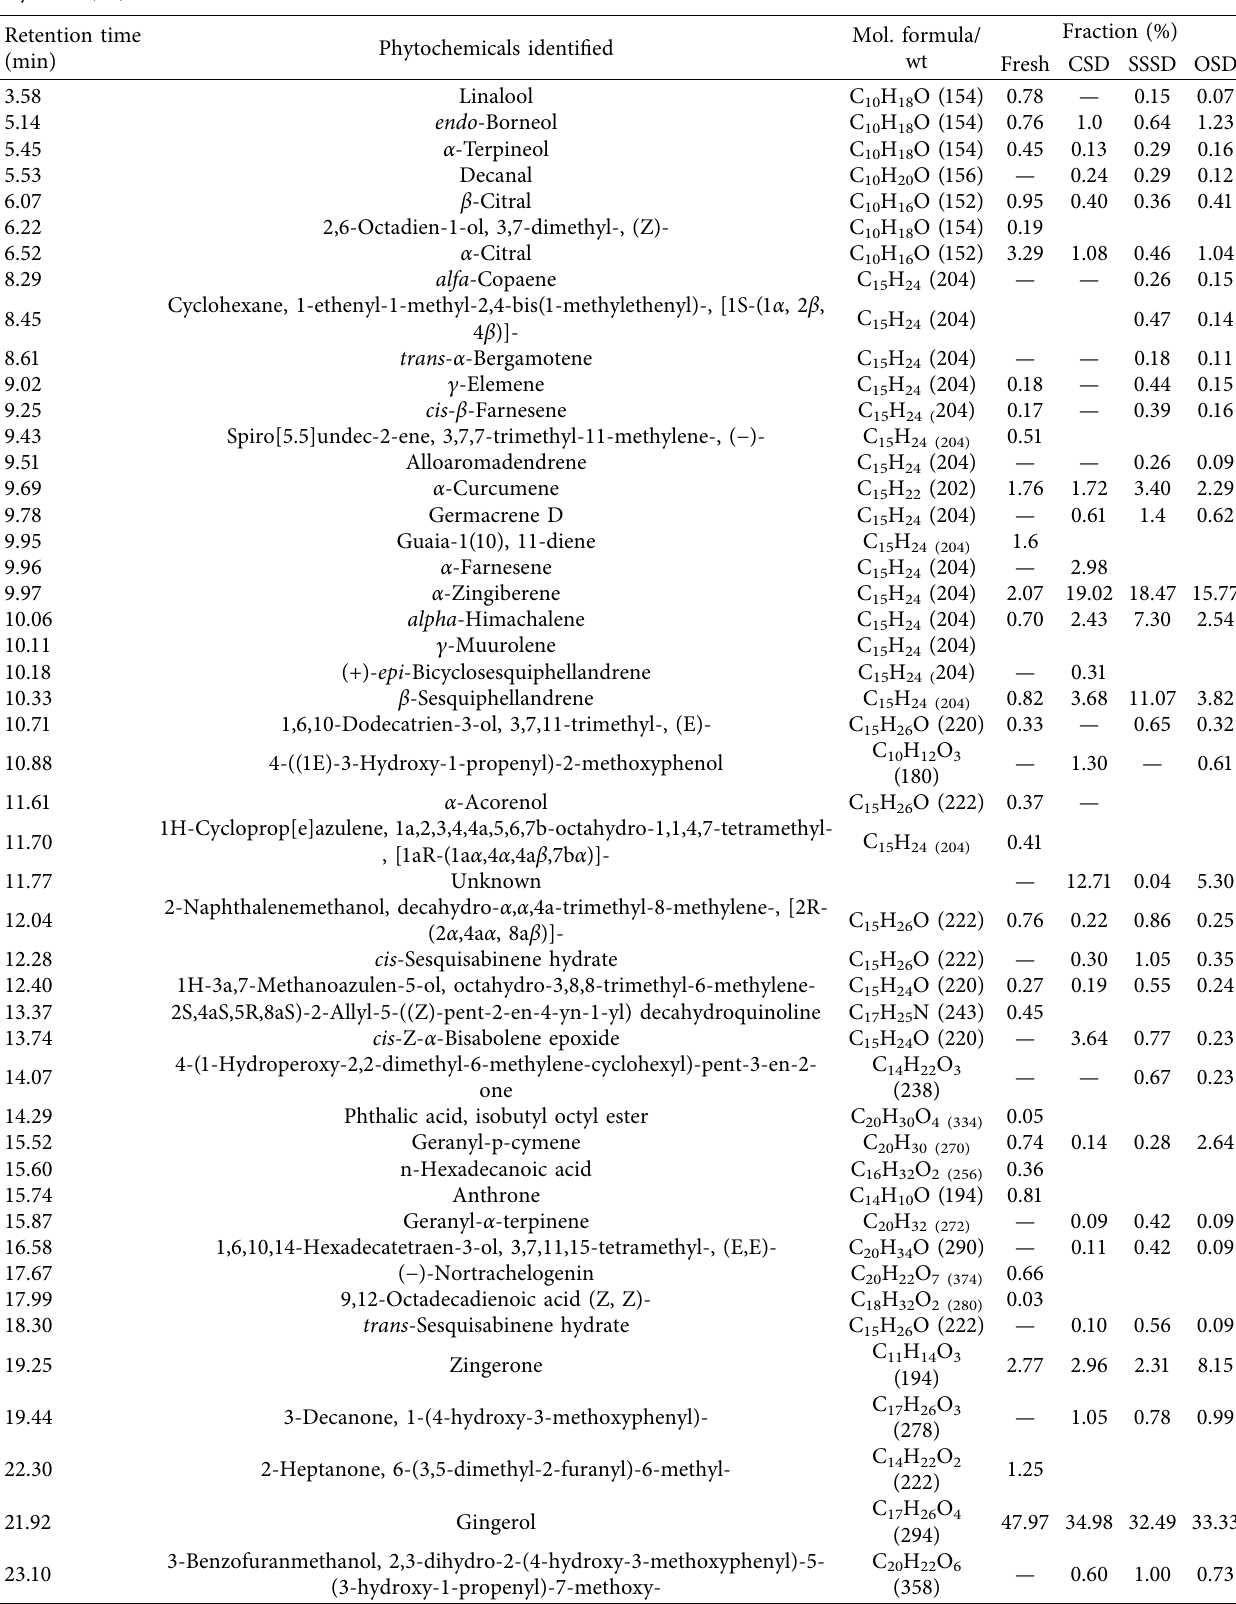
Table 2: Pungent and flavor compounds identified from the ethanol extract of Yellow ginger using different drying methods on dry basis